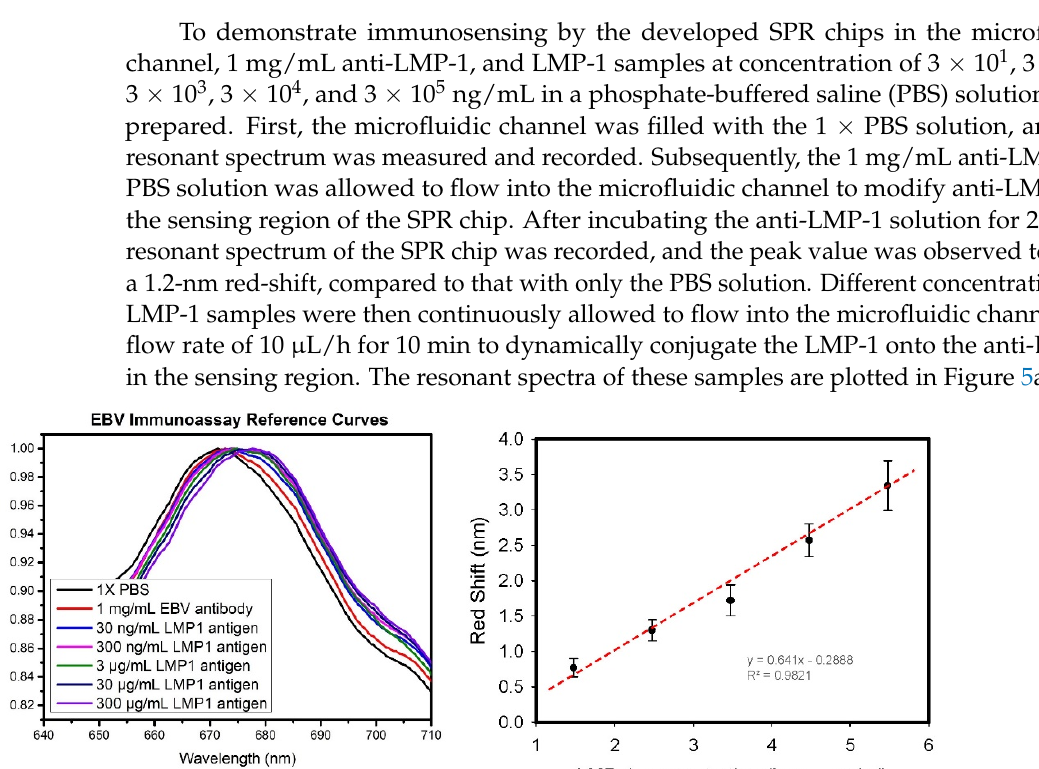
5 of 8 Figure 4. Sensitivity test. ( a ) Resonant spectra of the nanoslit SPR chip immersed in glycerol/water solutions with different refractive indices. ( b ) Curve fitting of the wavelengths of the resonant peaks.